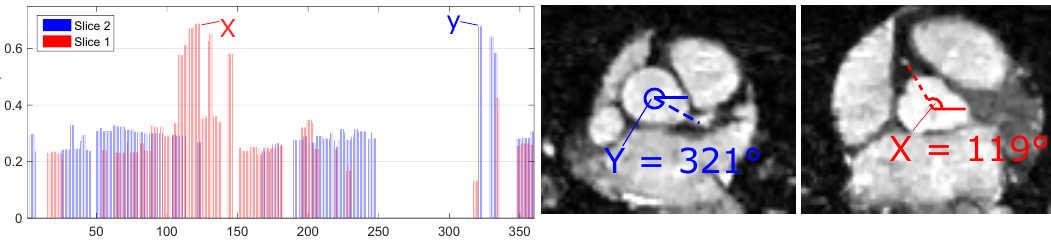
Figure 3. An example of the response plots created by the ostia detection method. The vessel response plots for the two slices on the left hand side are displayed at the right in the respective colors. X and Y denote the detected